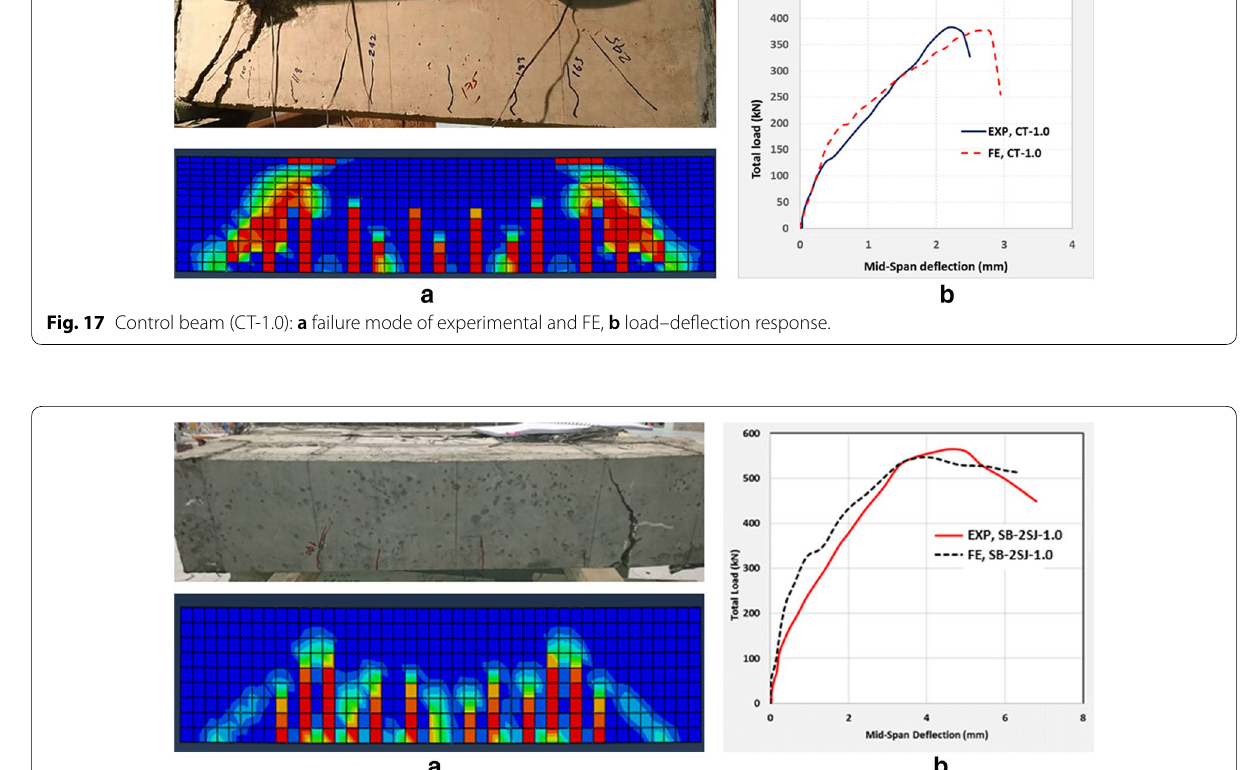
Fig. 18 Retrofitted l beam (SB‑2SJ‑1.0): a failure mode, b load–deflection response.